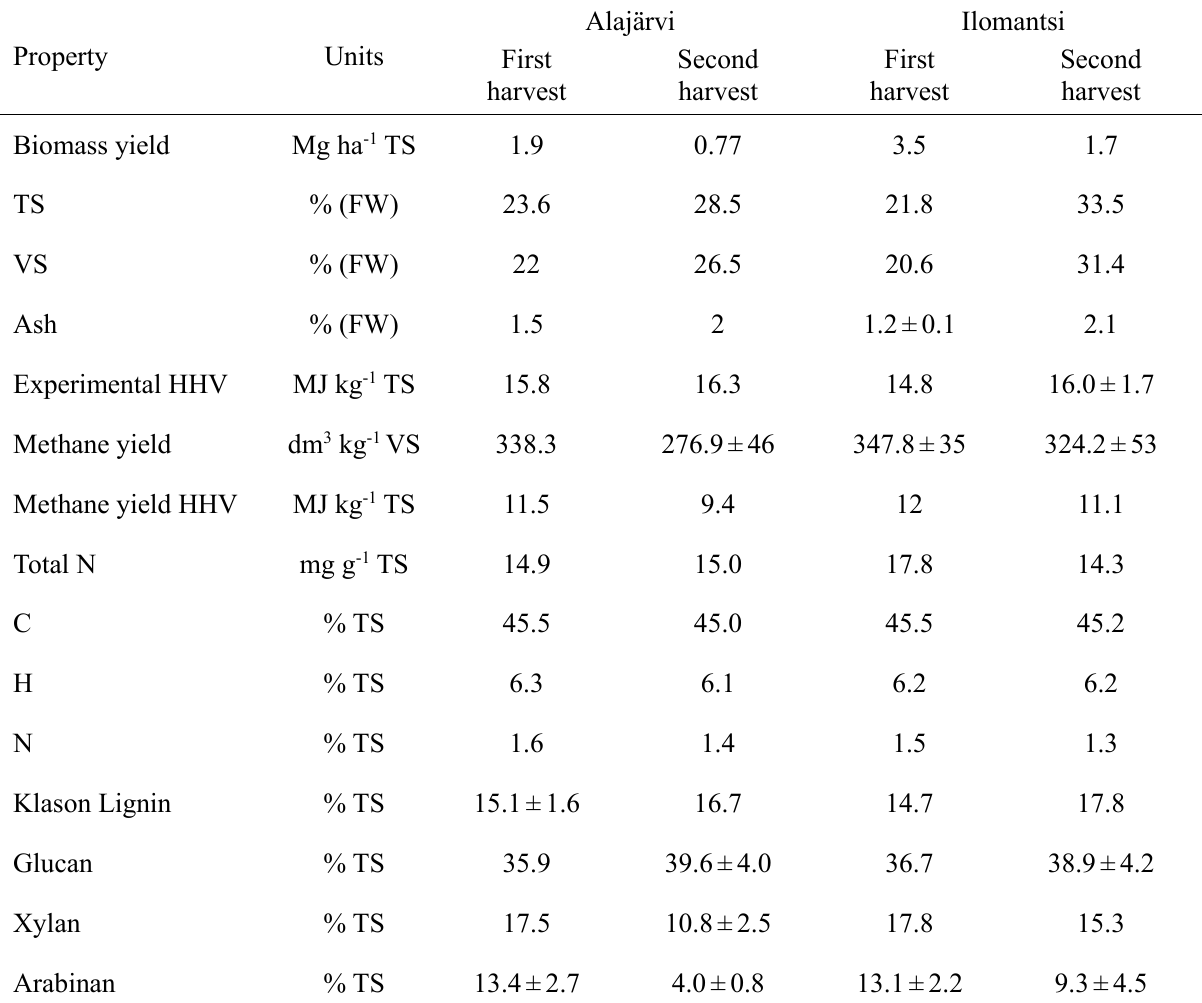
Table 4. The composition of freshly harvested RCG (two cuts) for biogas production and combustion. Standard deviation (±, of 3 separate replicates from the field samples) is not marked if it is less than 10 % of the mean value.